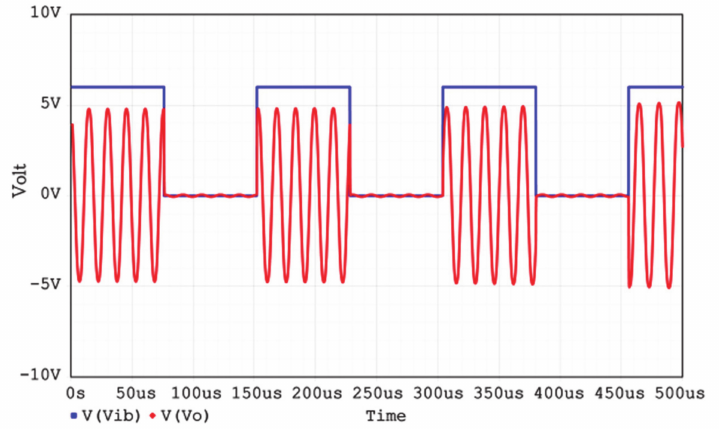
Figure 29. The simulation result of the ASK signal generator using pulse wave input signal.